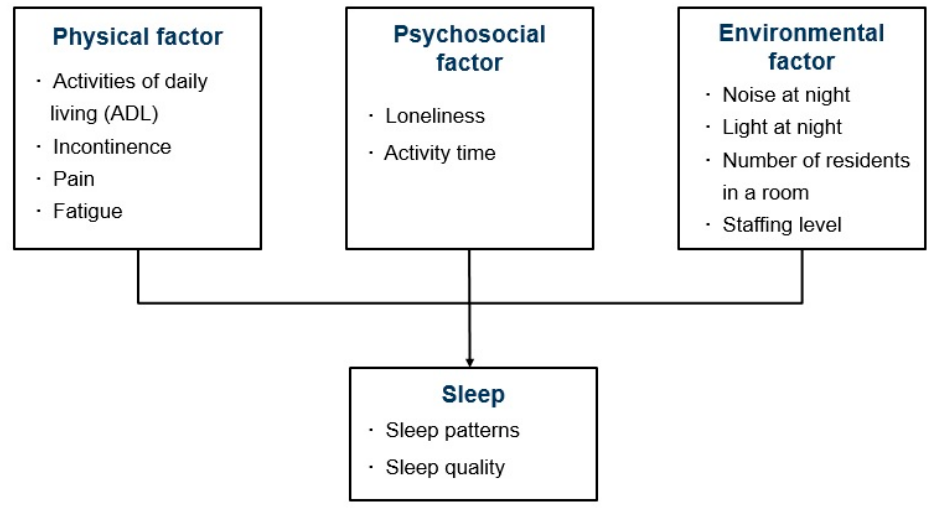
Figure 1. Conceptual framework of this study.